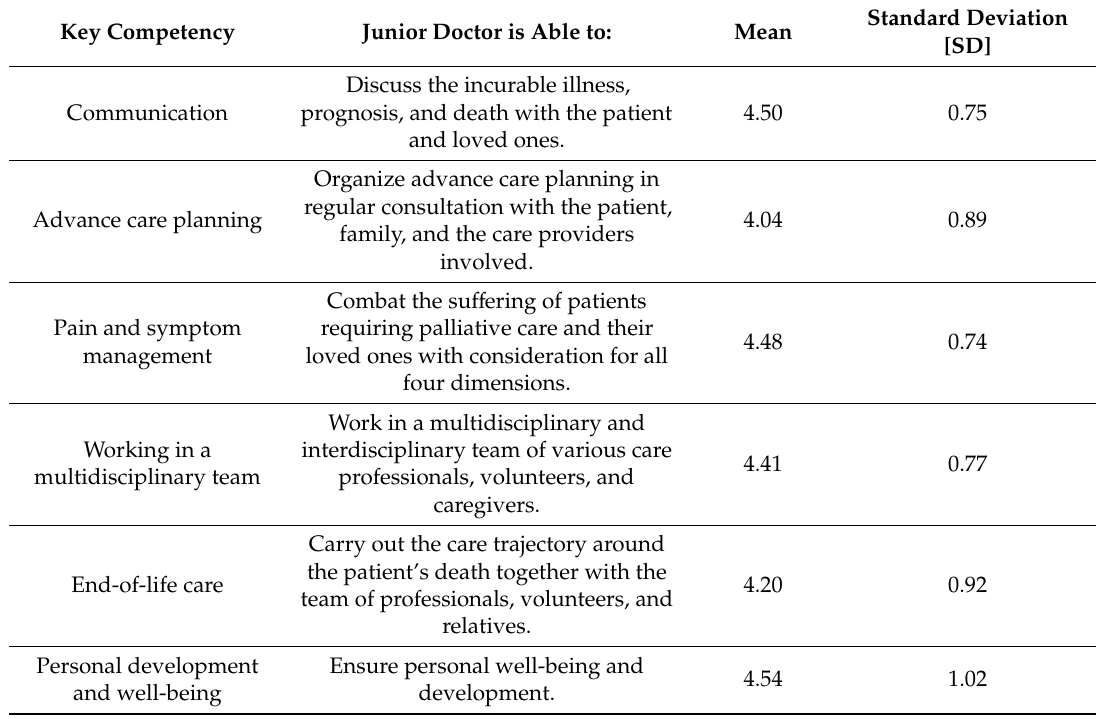
Table 2. Panel members’ mean ratings of the six key competencies in palliative care and their standard deviations ( N panel members = 54) (1–6 scale